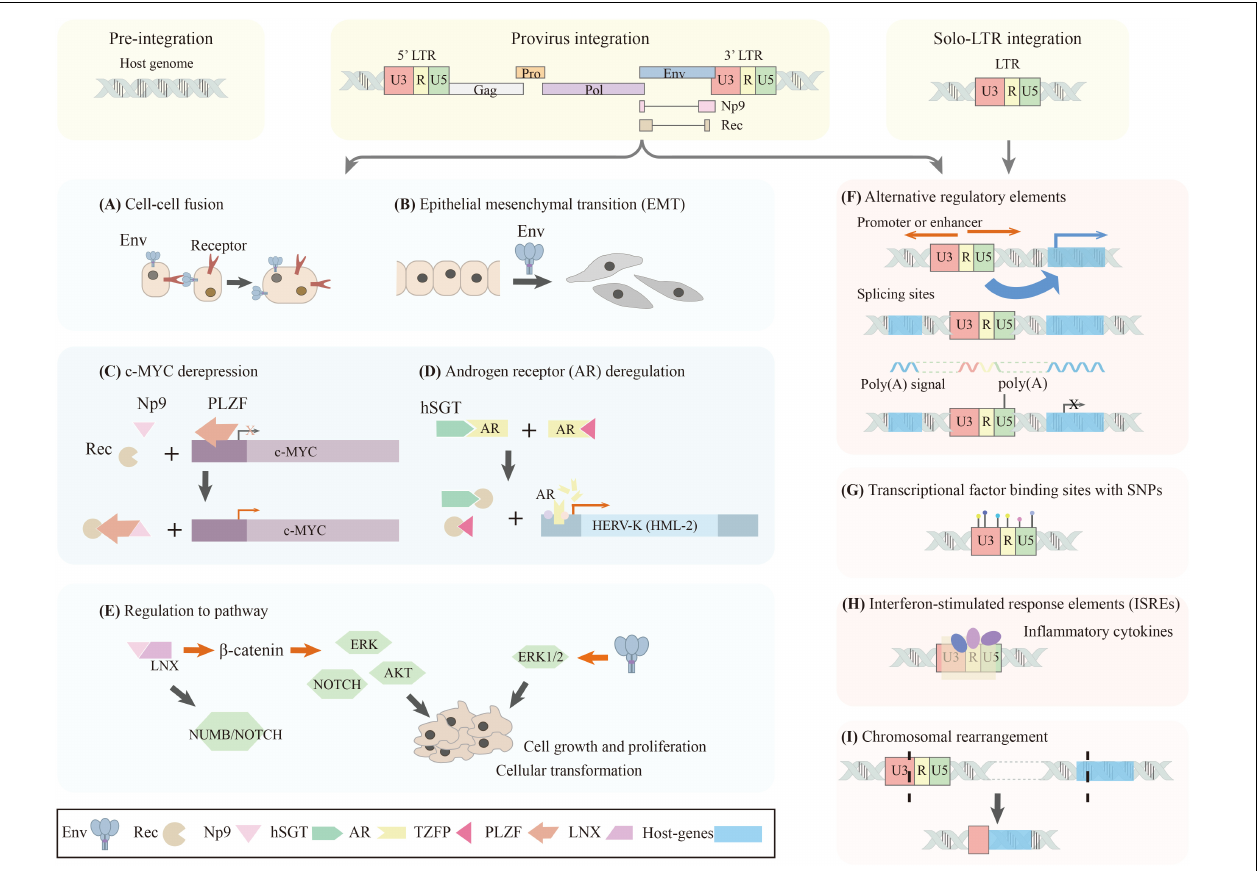
FIGURE 2 | Schematic diagram of potential pathogenetic mechanisms of HERV-K (HML-2). The polymorphic integrated HERV-K (HML-2) locus can have three different status in different individuals, including: (i) Pre-integration: without both viral protein coding sequences and LTRs; (ii) Provirus integration: possesses both viral protein coding sequences and LTRs; (iii) Solo-LTR integration: only possesses an LTR sequence. The presence or absence of viral proteins coding sequences or LTRs may reveal different pathogenetic mechanisms: (A–E) show viral proteins produced by HERV-K (HML-2) cause aberrant biological phenomenon; (F–I) show regulatory functions of LTRs. (A,B) Env protein induces cell-cell fusion and epithelial mesenchymal transition (EMT) which could contribute to tumorigenesis. (C,D) Accessory proteins, Rec and Np9, are suggested as oncogenic proteins causing c-myc depression and androgen receptor deregulation. (E) Viral proteins, such as Env and Np9, can regulate different signal pathways related to cell growth and proliferation. (F) LTRs can significantly affect their proximal host genes in addition to regulating viral gene expression because of the possession of regulatory elements. LTRs can act as alternative promoters, enhancers, splicing sites, and poly (A) signals. (G) LTR sequence variation, causing transcription factor binding site polymorphism, induce different promoter expression patterns. (H) The presence of interferon-stimulated response elements (ISREs) in the promoter region of HERV-K (HML-2) suggests its expression could be regulated by inflammatory cytokines. (I) LTR-derived chromosomal re-arrangement can induce aberrant expression profile of host genes. Polymorphic integration, a same HERV-K (HML-2) locus showing different status in different individuals, may causing different expression profile of both the viral proteins and their proximal host genes, can be a possible avenue to study the pathogenic functions of HERV-K